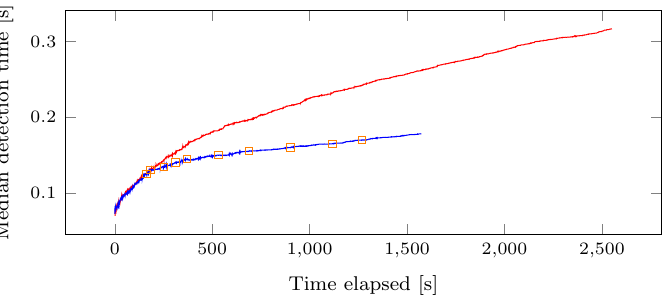
Figure 10. Evolution of median detection time of RICE-Sy with (bottom) and without (top) the user-oriented strategy. The orange squares show when the QHL is partitioned for a user. Only the first 5000 measurements are displayed for readability